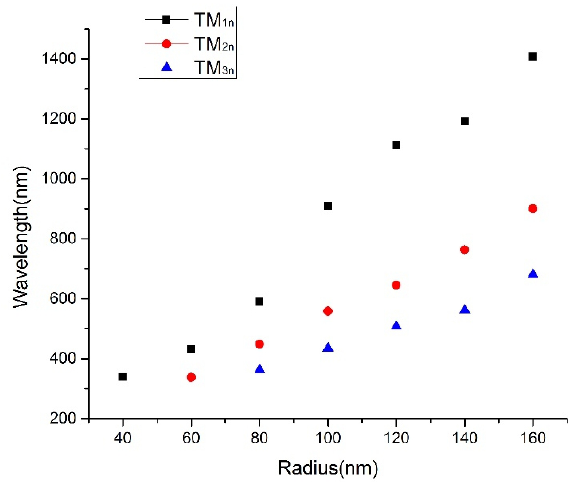
Figure 6: Correlation of the volumetric TM modes’ excitation wave- length with NW radius allows optimization of cavity for absorption and emission at desired